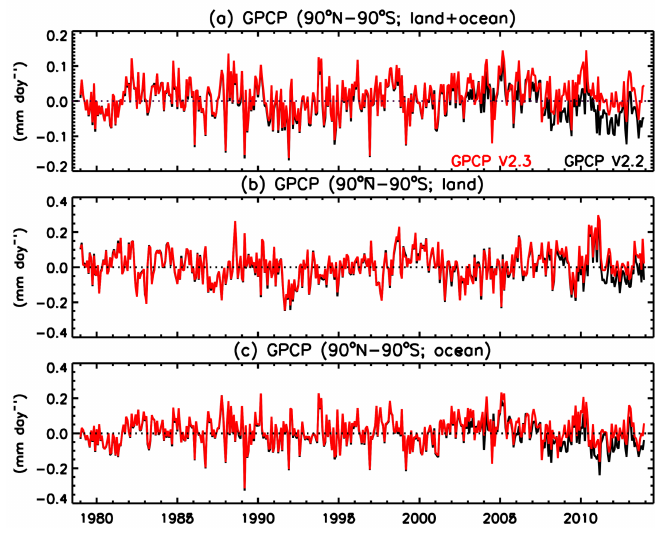
Figure 1. Time series of the Global Precipitation Climatology Project (GPCP) V2.2 (black) and V2.3 (red) global mean precipitation anomalies based on the 1979–2013 GPCP V2.2